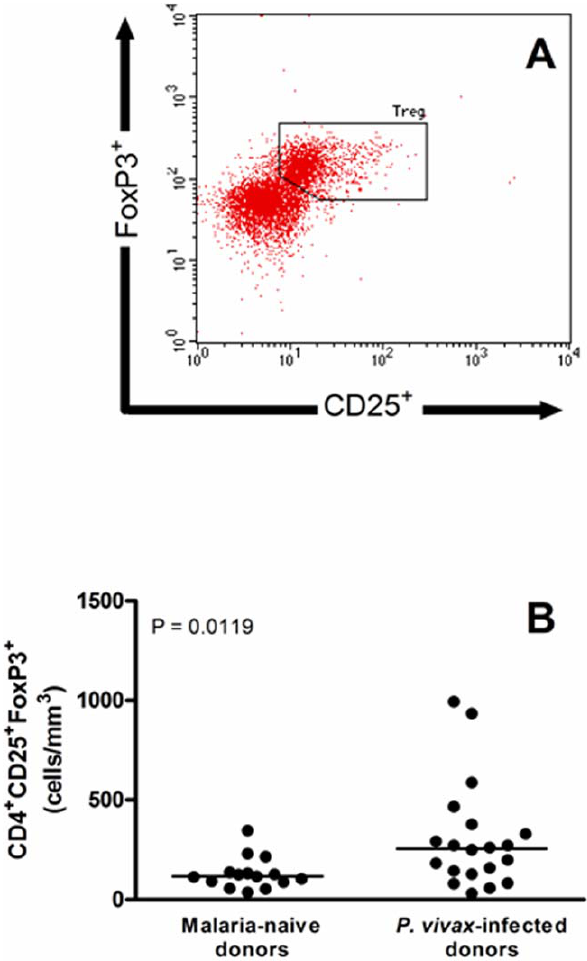
Figure 1. Flow cytometric analysis of regulatory T cells. (A) CD25 and FoxP3 expression in gated CD4 + CD3 + lympho- cytes. Dot plot show a representative data of 35 donors examined. (B) Absolute numbers of circulating CD4 + CD25 + FoxP3 + regulatory T cells in malaria-naı¨ve and P. vivax -infected donors (n=15 and 20, respectively). Absolute numbers (cells/mm 3 ) are indicated on Y-axis and lines represent median. Statistical differences were detected using Mann-Whitney U test and are indicated on the graph with significant P values.